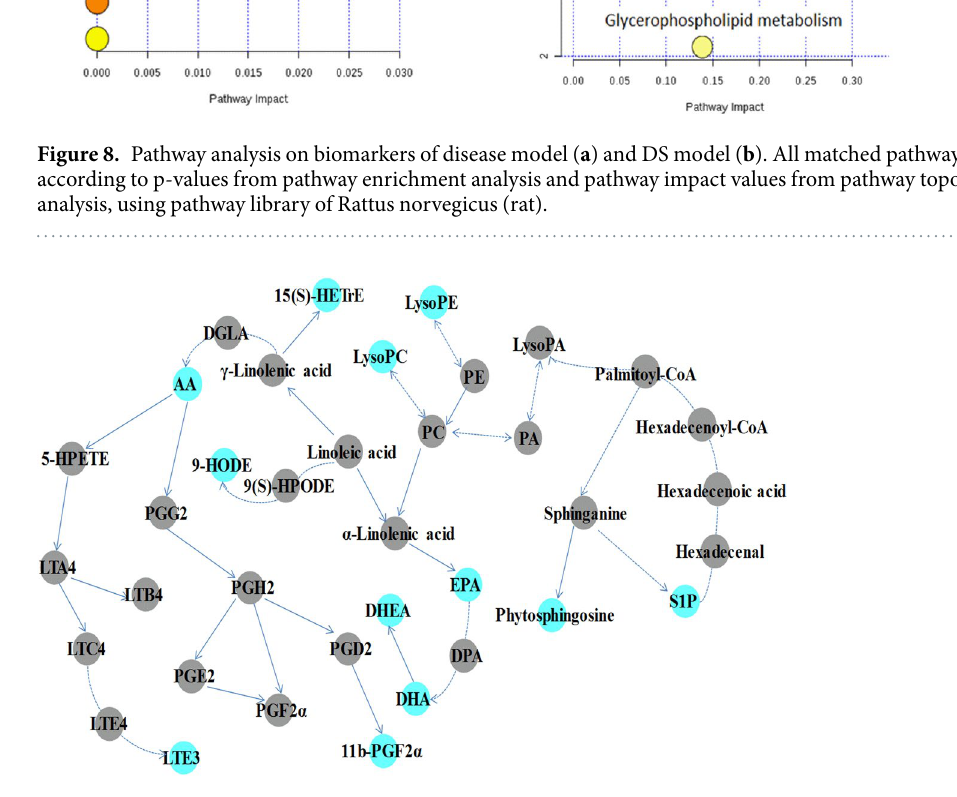
Figure 9. Biosynthetic pathways for parts of potential biomarkers related to arachidonic acid metabolism, linoleic acid metabolism, glycerophospholipid metabolism and sphingolipid metabolism. The colored dots showed metabolites identified in the current study. DGLA: dihomo- γ -linolenic acid; 15S-HETrE: 15(S)- hydroxyeicosatrienoic acid; AA: arachidonic acid; LTE3: leukotriene E3; EPA: eicosapentaenoic acid; DHA: docosahexaenoic acid; DHEA: 8, 11, 14-eicosatrienoyl ethanolamide; S1P: Sphingosine